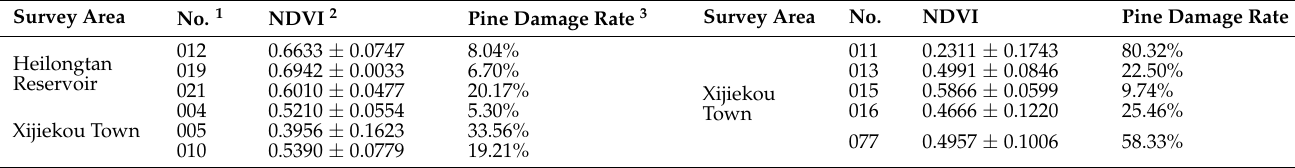
Table 5. The pine victimization rates and NDVI of the sample